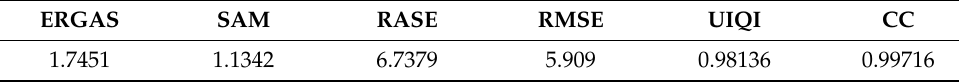
Table 1. Results obtained without derivative.